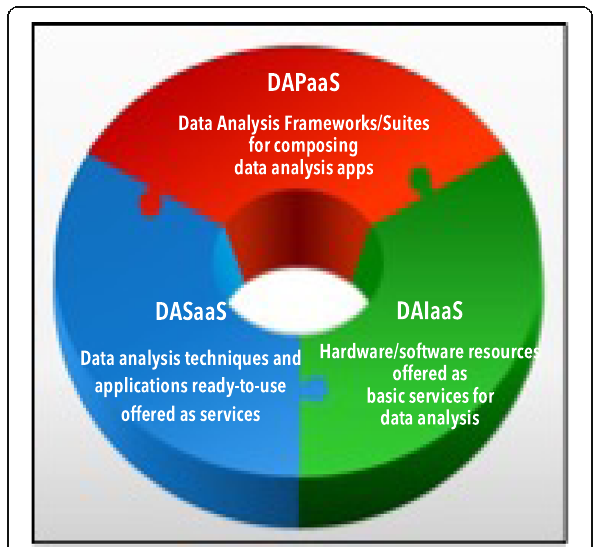
Fig. 1 The three models of the DAaaS software methodology. The DAaaS software methodology is based on three basic models for delivering data analysis services at different levels (application, platform, and infrastructure). The DAaaS methodology defines a new model stack to delivery data analysis solutions that is a specialization of the XaaS (Everything as a Service) stack and is called Data Analysis as a Service (DAaaS). It adapts and specifies the three general service models (SaaS, PaaS and SaaS), for supporting the structured development of Big Data analysis systems, tools and applications according to a service-oriented